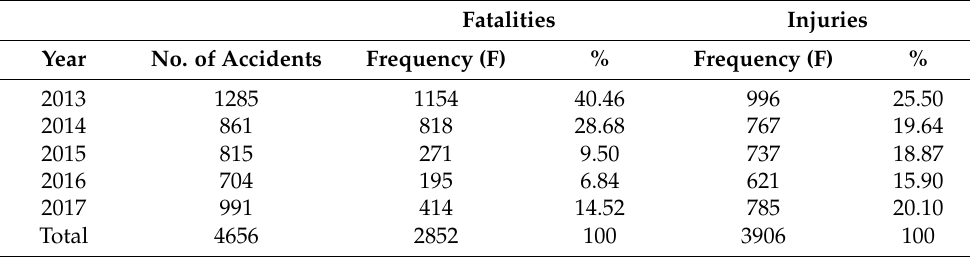
Table 1. Accident severity along Lokoja − Abuja-Kaduna highway.